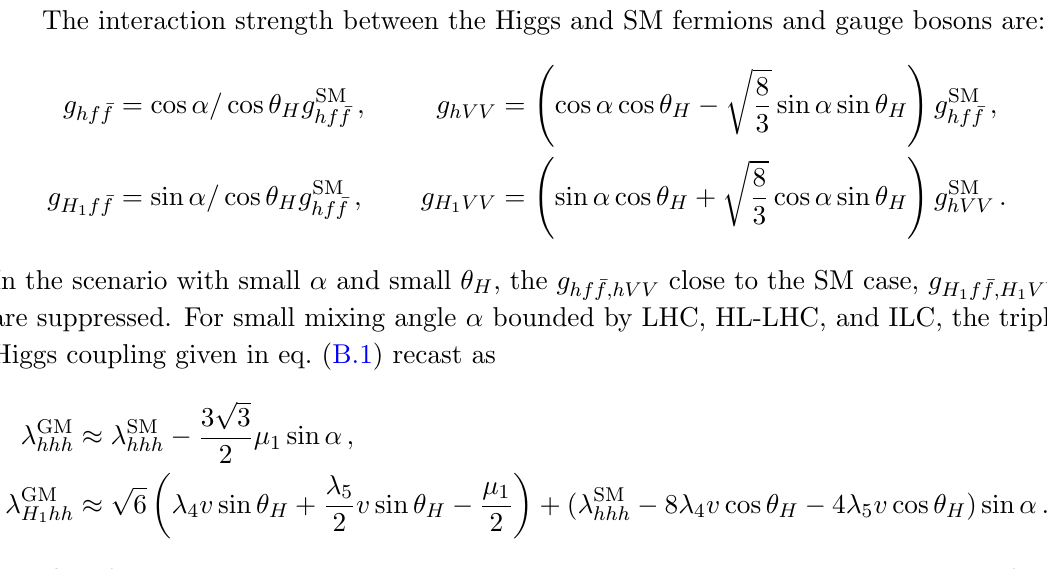
for one-step phase 5